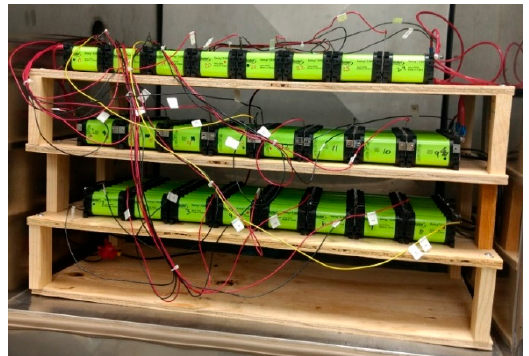
Figure 6. Li ion battery with 24S-8P cells.